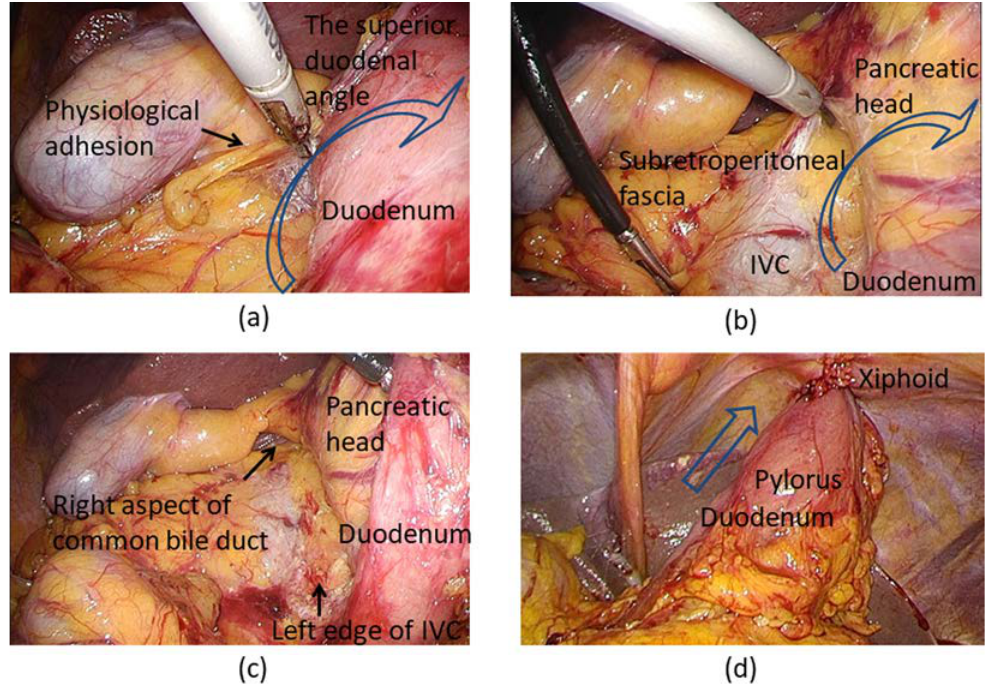
Figure 1 Kocher maneuver. (a) The assistant surgeon pulls the duodenum up and left from the patient’s left side (arrow), and the operating surgeon removes the physiological adhesions on the cranial aspect from the patient’s right side. (b) The duodenum in combination with the pancreatic head is extensively mobilized (arrow) on the subretroperitoneal fascia. (c) The landmarks of sufficient mobilization are exposure of the left edge of the inferior vena cava and the right aspect of the common bile duct. (d) The Kocher maneuver results in sufficient elevation of the 3-cm-wide gastric conduit toward the xiphoid, which is the entrance of the retrosternal route (arrow). IVC, inferior vena cava